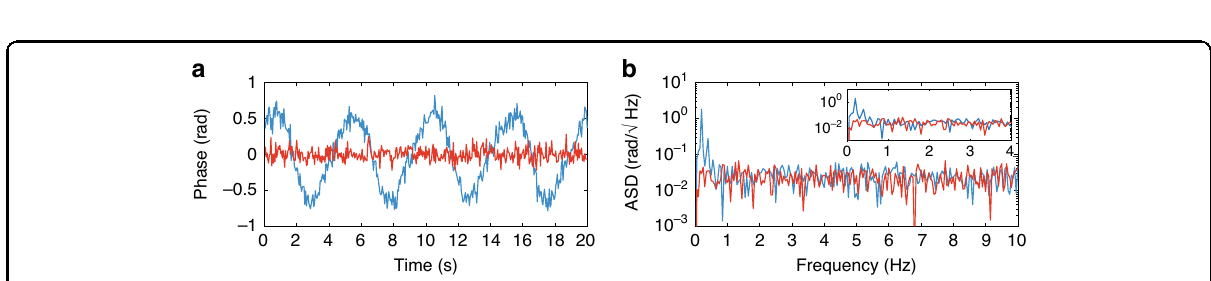
Fig. 3 Temperature sensing by the time-expanded Φ OTDR. a Dynamic temperature map around the perturbed area. b Experimentally obtained temperature pro fi le around the maximum (blue line) and expected (dashed red line) pro fi les. The latter was obtained by assuming a constant temperature pro fi le along the hotspot; thus, the square-shaped pro fi le of the hotspot is convolved with the 2 cm resolution window given by the gauge length. This results in a triangular shape for the measured temperature pro fi le